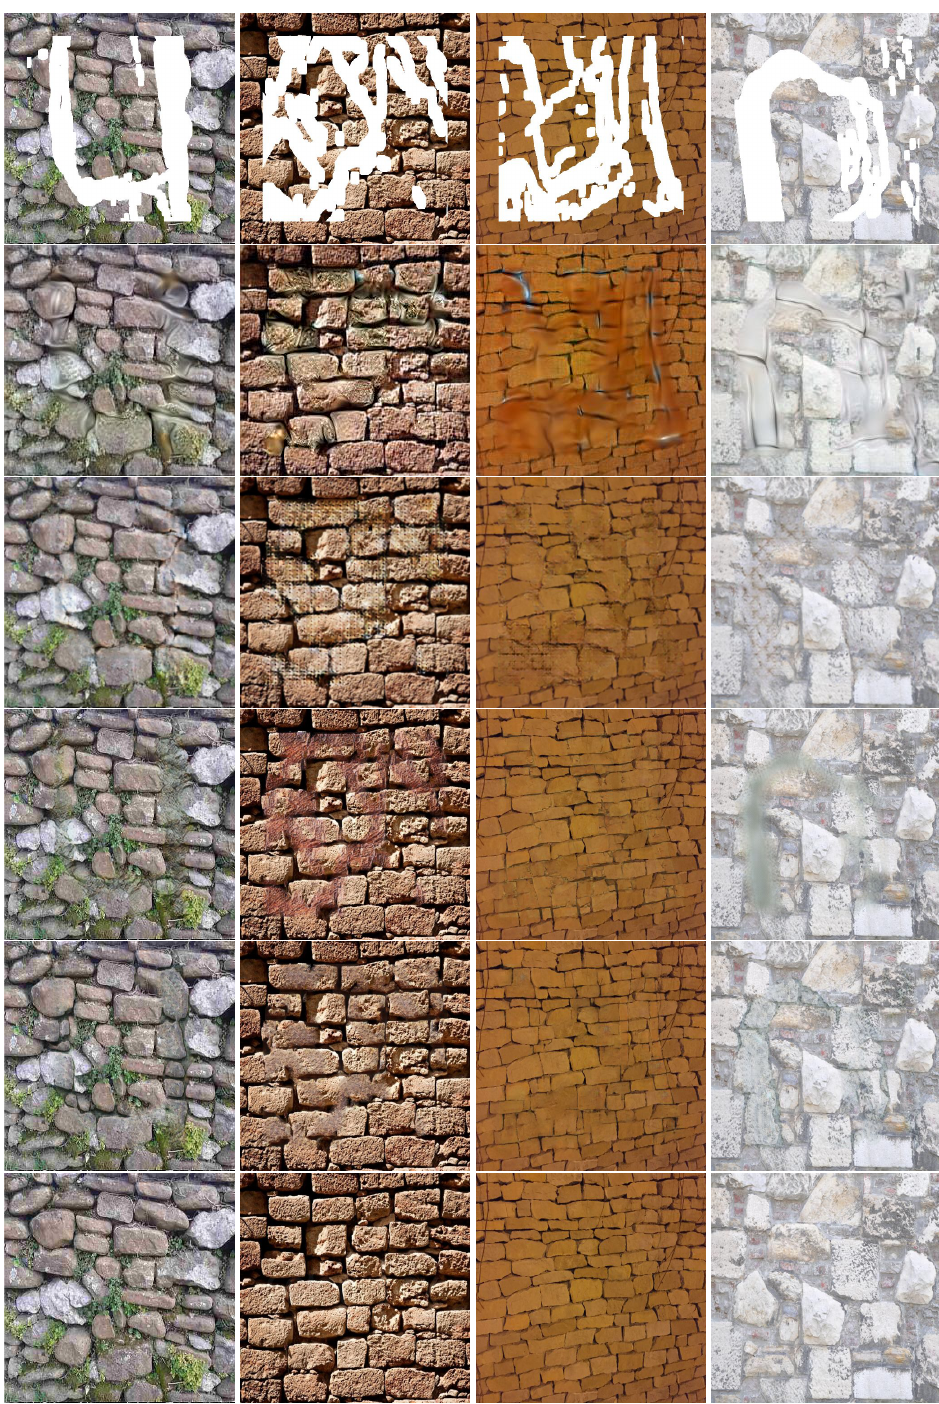
Figure 9. Comparing our method to three non-blind state-of-the-art inpainting algorithms for four samples in the test dataset shown in the different columns. First row: input images with synthetic occlusions, Second row: GMCNN output [38], Third row: Pluralistic Image Inpainting output [40], Fourth row: Canny based EdgeConnect output [42], Fifth row: output of our proposed approach, Sixth row: Ground